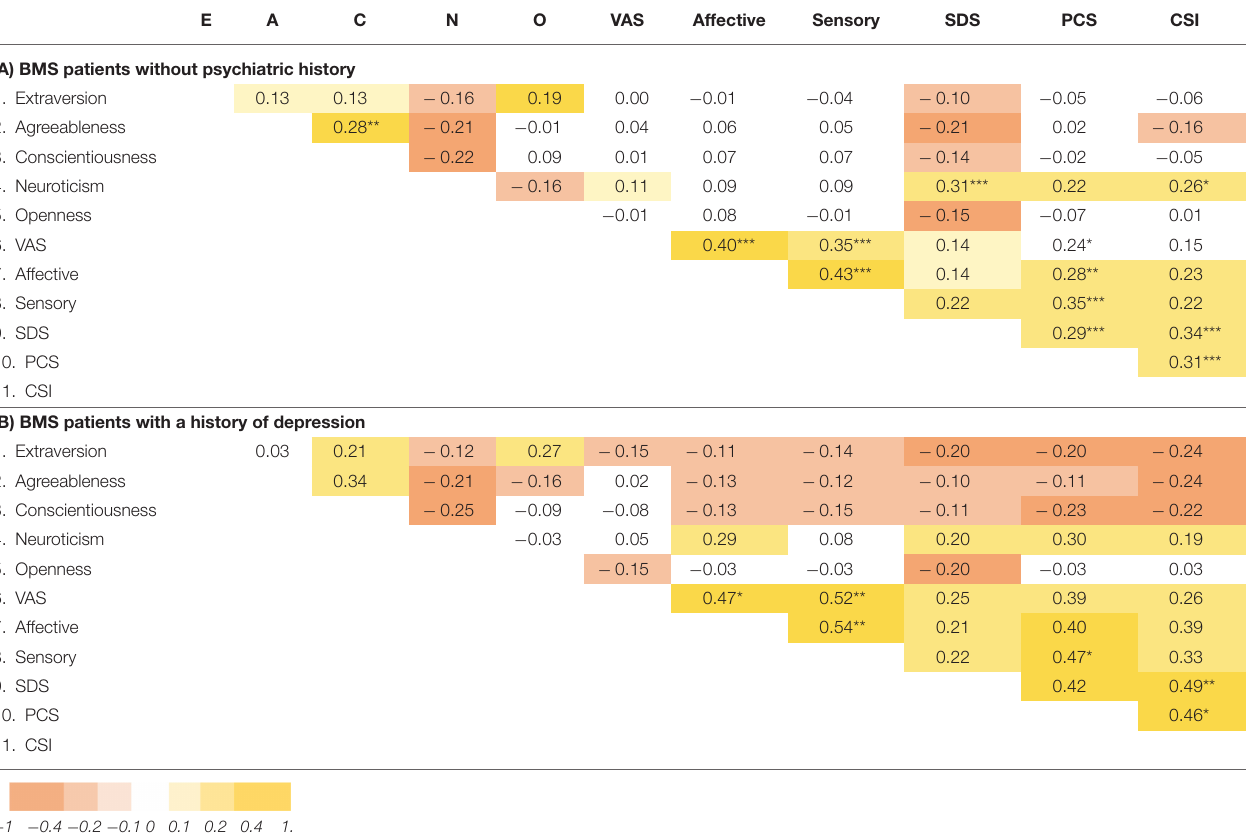
TABLE 2 | Correlations between measures (unstandardized, Kendall’s rank correlation tau , P-values were adjusted for multiple tests). E A C N O VAS Affective Sensory SDS PCS CSI